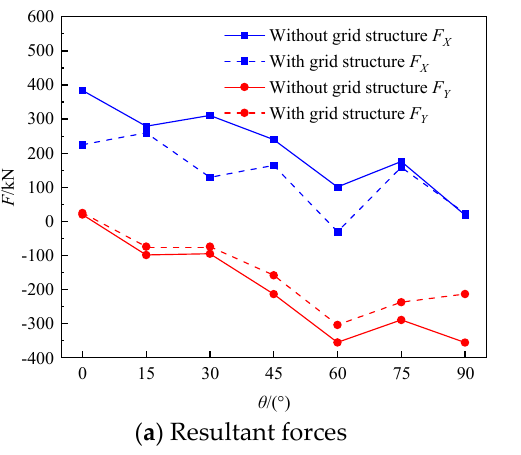
Figure 38. Wind load of the core tube with and without the grid structure.